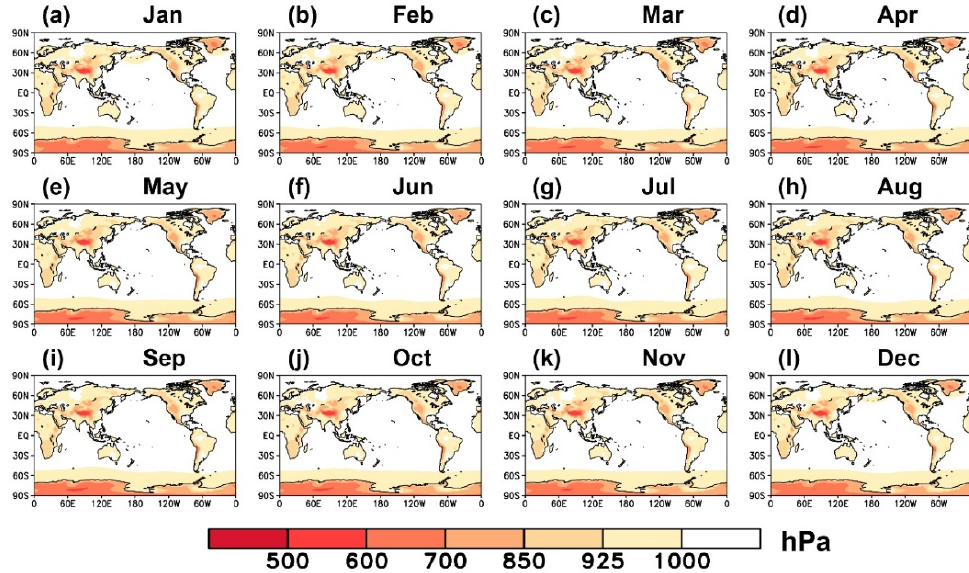
Figure 2. Global distribution of the mean state of the surface pressure from the MRM during 1979–2018. ( a – l ) The surface pressure from January to December. The units for the surface pressure are hPa.